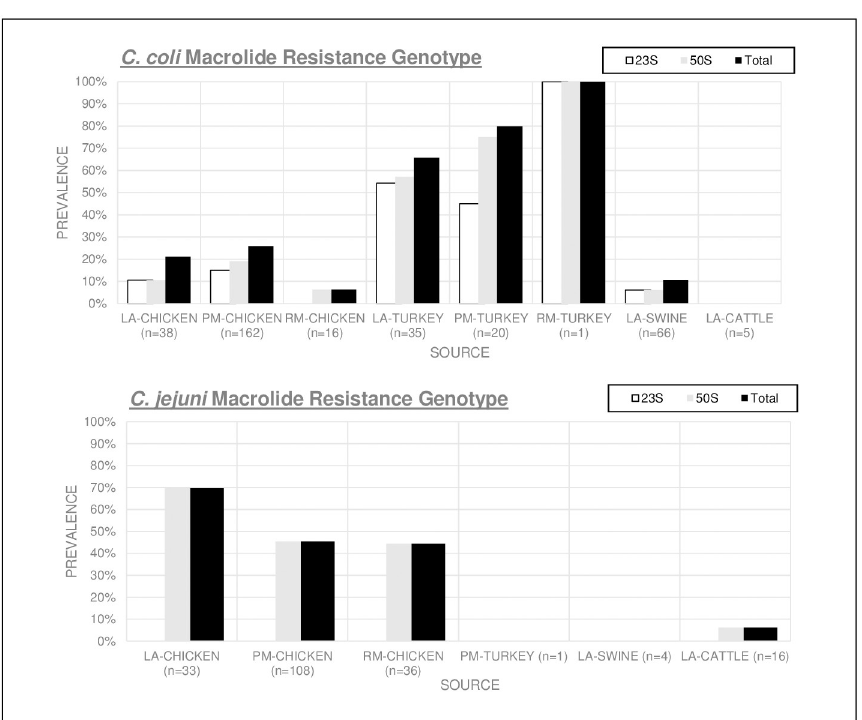
Fig 5. C . coli and C . jejuni AMR gene prevalence by source conferring macrolide resistance. Chart coding: Live Animal (LA), Processed Meat (PM), Retail Meat (RM).